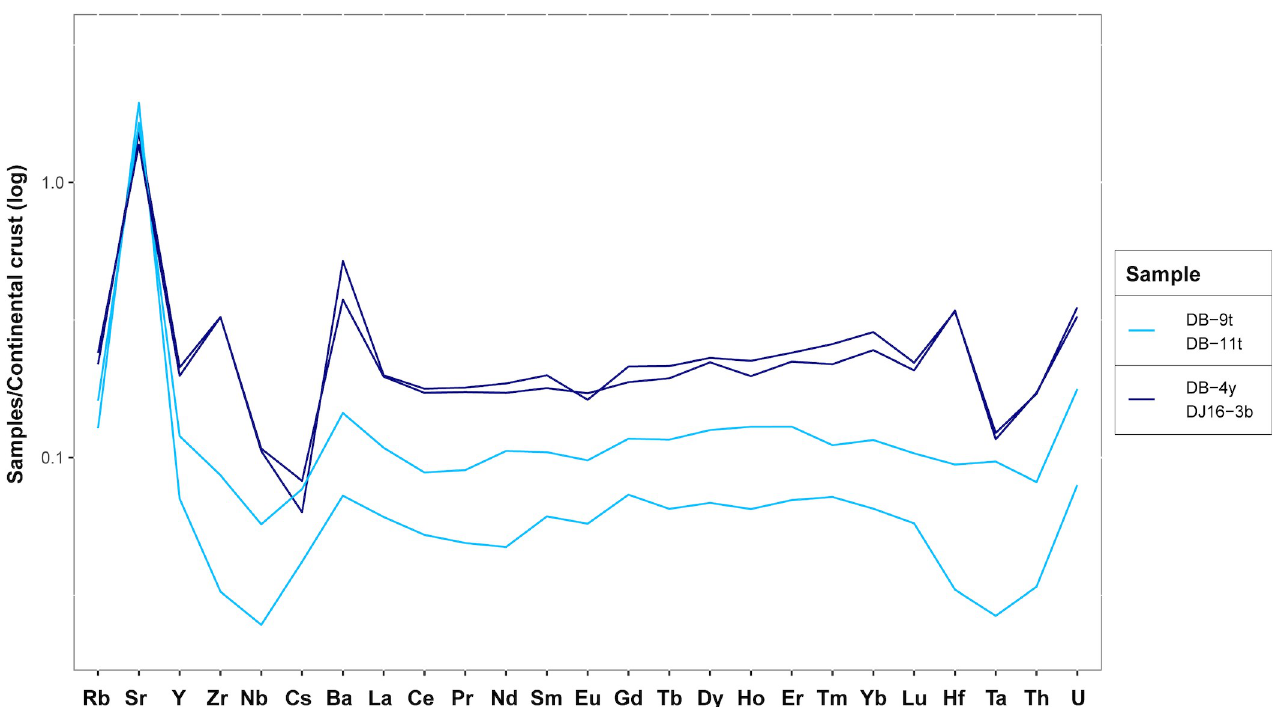
Fig 8. Subdivision of the high magnesia samples based on trace element content.